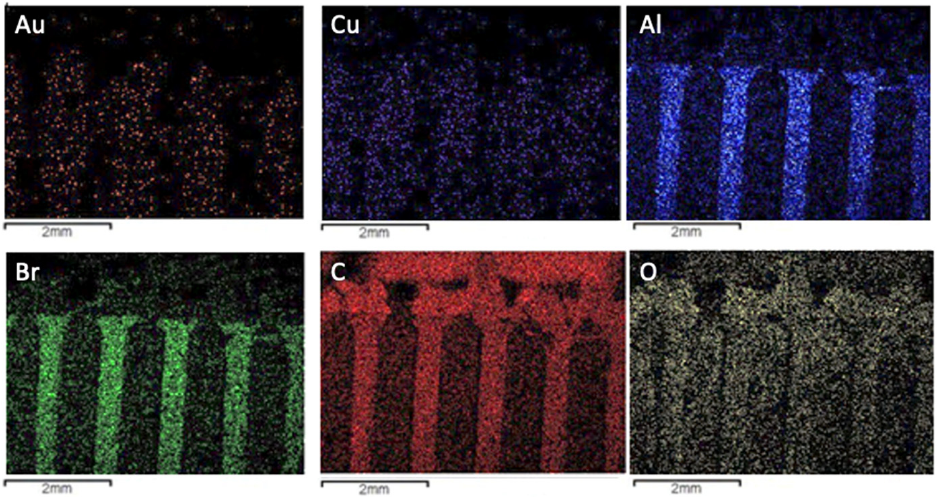
Figure 8. Chemical mapping of the most relevant elements detected in the microanalysis of the dark and bright areas of the Type 3 WEEE sample.